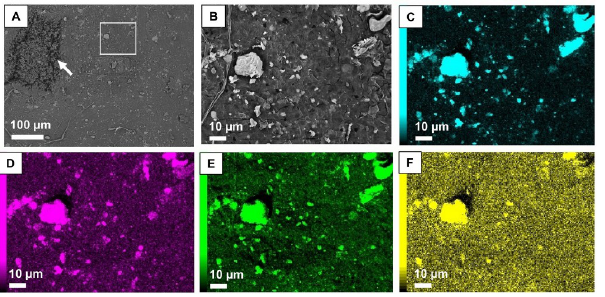
Fig 6. Back-scattered images (BSI) and the result of map analysis of the upper surface of lichens, Punctelia borreri on Zelkova serrata . (A) BSI with a magnification of 200. The square indicates the observation and analysis areas from (B) to (F). The arrow shows pseudocyphellae. (B) to (F) show images with a magnification of 1,000. (B) shows BSI and, each image of (C) to (F) shows the distribution of Si, Al, O, and Mg,